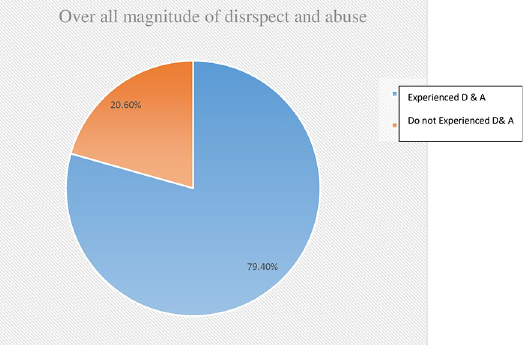
Fig 1. Overall magnitude of disrespect and abuse (D & A) during facility-based childbirth in Borena District, Amhara region, Ethiopia, 2020 (n =